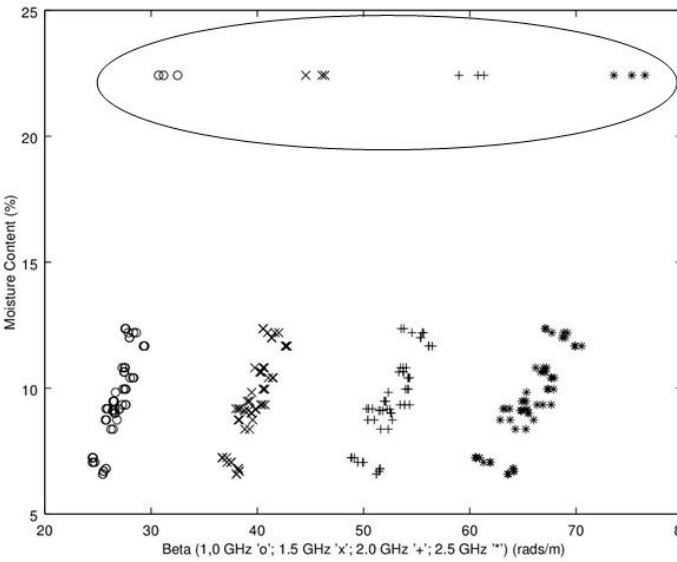
Figure 17. Propagation delay constant, β , versus moisture content at 1.0, 1.5, 2.0 and 2.5 GHz. The points circled are from the excessively wet low-density module.